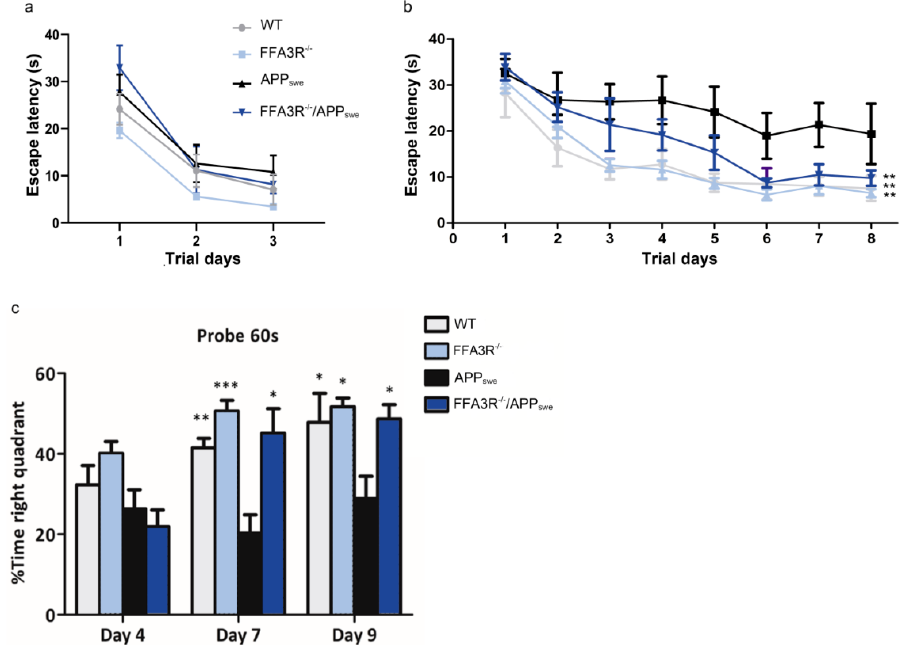
Figure 3. FFA3R − / − /APP swe mice do not show the cognitive deficit of 12-month-old APP swe mice. Escape latency times of the visible ( a ) and hidden platform ( b ) in the MWM test for the WT, FFA3R − / − , APP swe , and FFA3R − / − /APP swe mice in the different trial days. ( c ) Percentage of time spent searching for the target quadrant of the probe test for the WT, FFA3R − / − , APP swe , and FFA3R − / − /APP swe on day 4, 7, and 9. Results are expressed as mean ± SEM (n = 10–12 in each group). * p < 0.05, ** p < 0.01, *** p < 0.001 vs. APP swe .